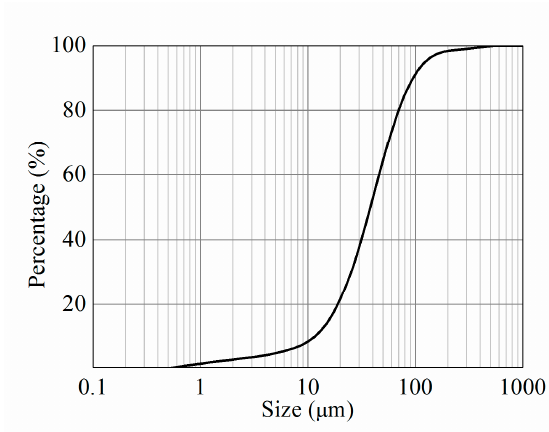
Figure 1. Particle size distribution curve of the tested soil.